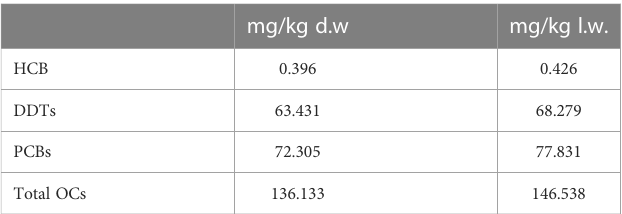
TABLE 1 OCs levels in the blubber of the stranded